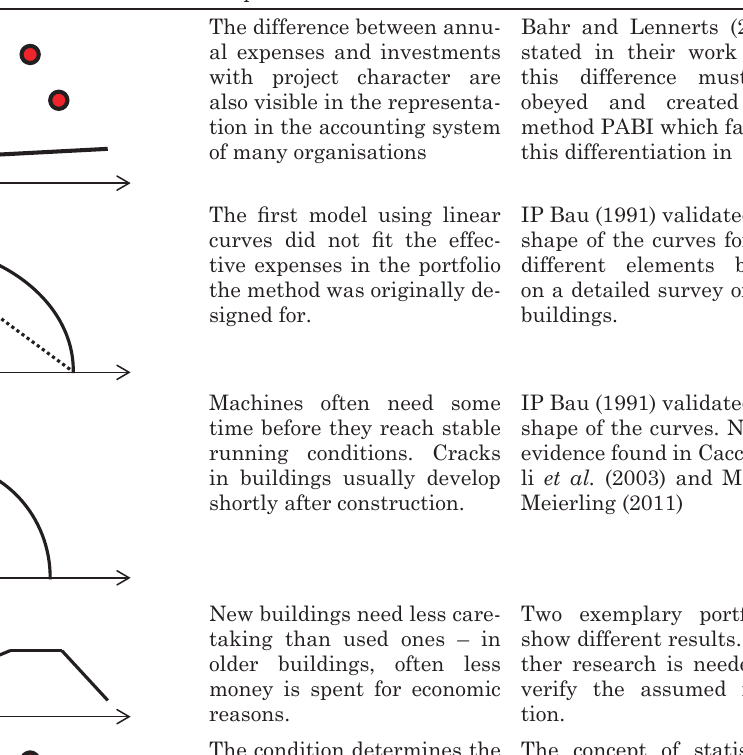
Table 2. Validation of assumptions the method Schroeder is based upon [units of diagrams]